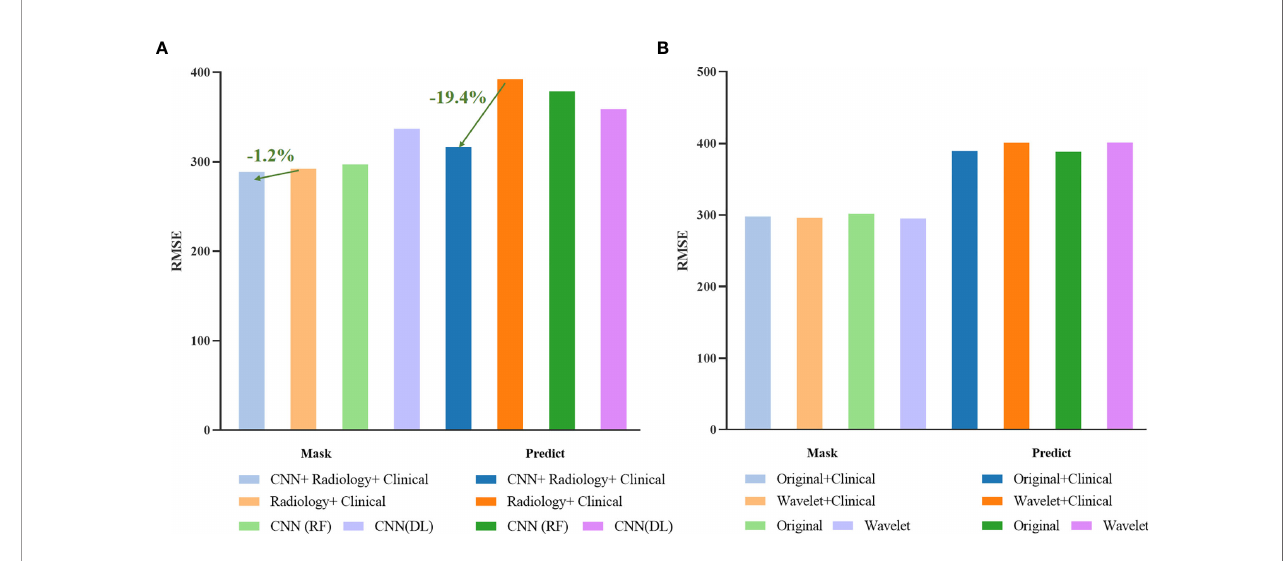
FIGURE 15 | Histogram of survival prediction results.